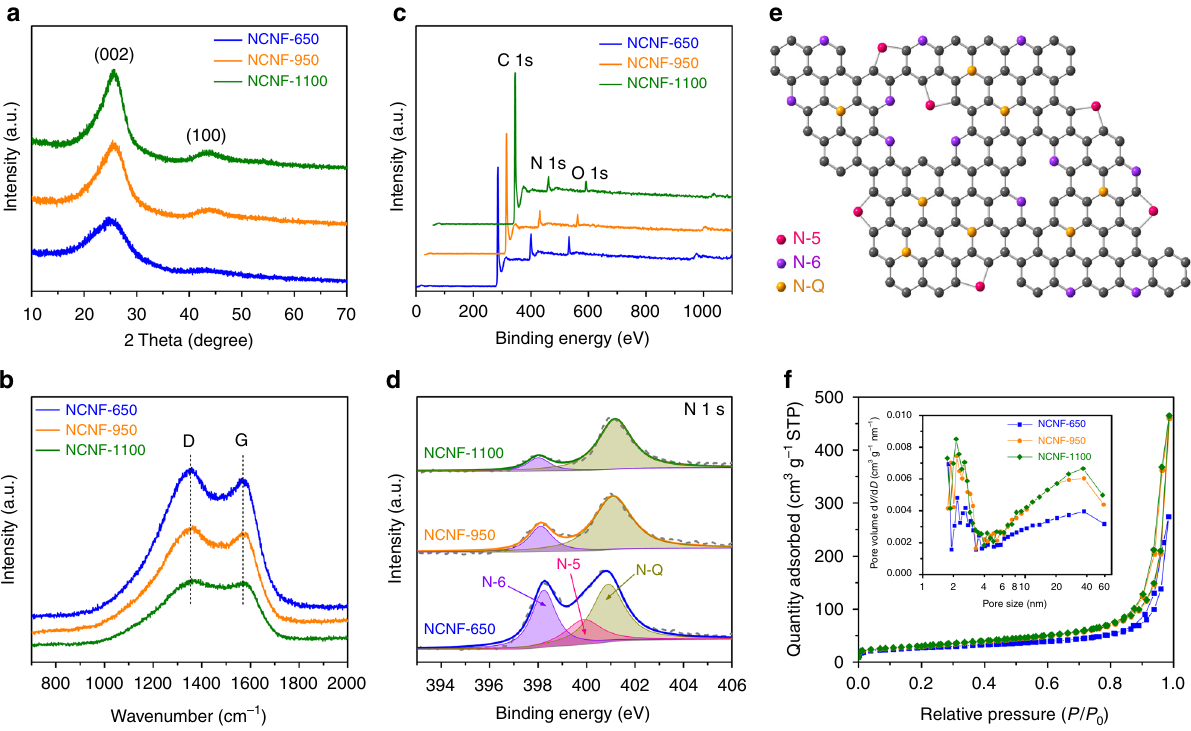
Fig. 2 Structure characterizations of NCNFs by spectroscopies. a XRD patterns. b Raman spectra. c XPS survey spectra. d N 1s core level XPS high- resolution spectra. e A schematic illustrating the structure of the N-doping species. f Nitrogen adsorption – desorption isotherms (inset shows the related pore size